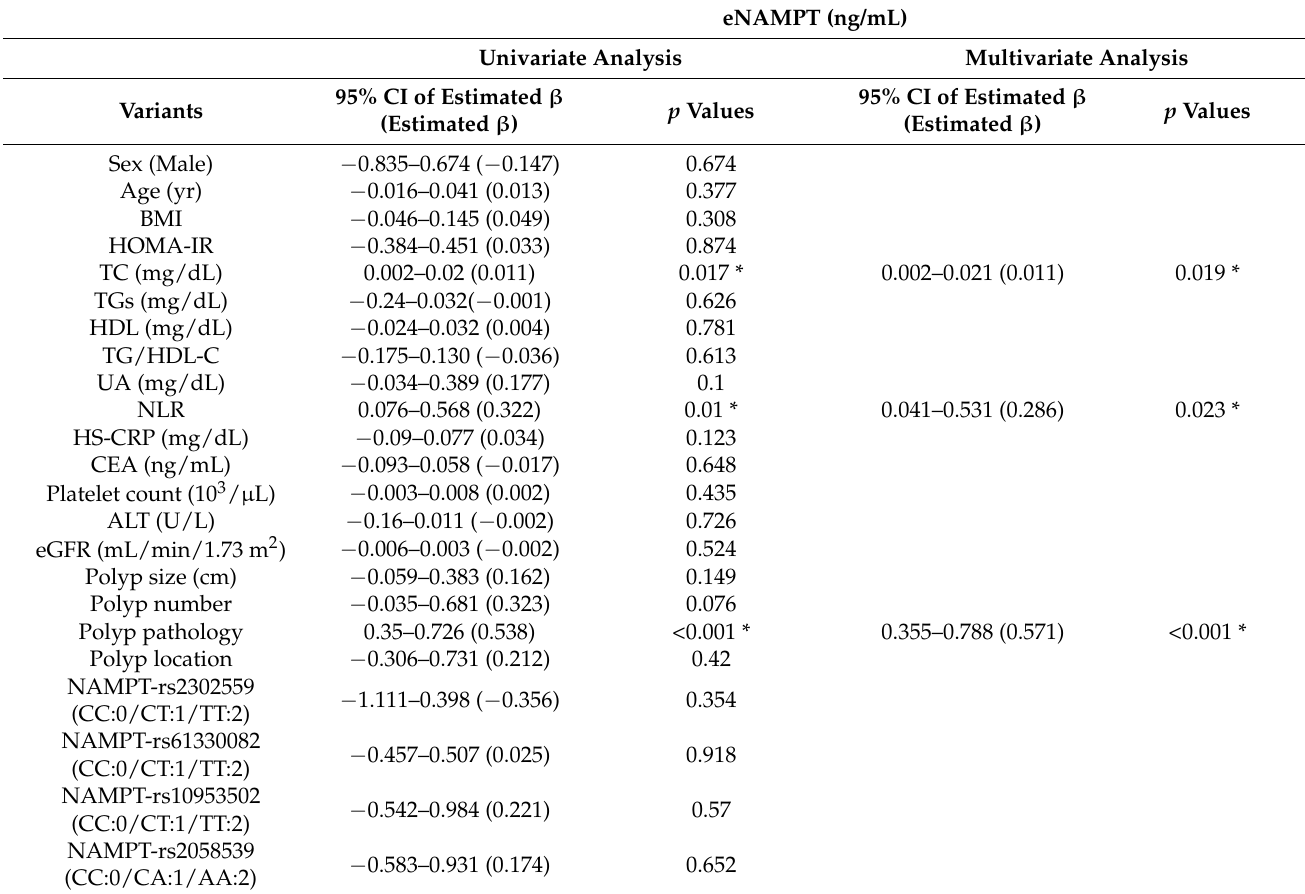
Table 2. Univariate and multivariate analyses of factors associated with baseline eNAMPT levels. eNAMPT (ng/mL) Univariate Analysis Multivariate